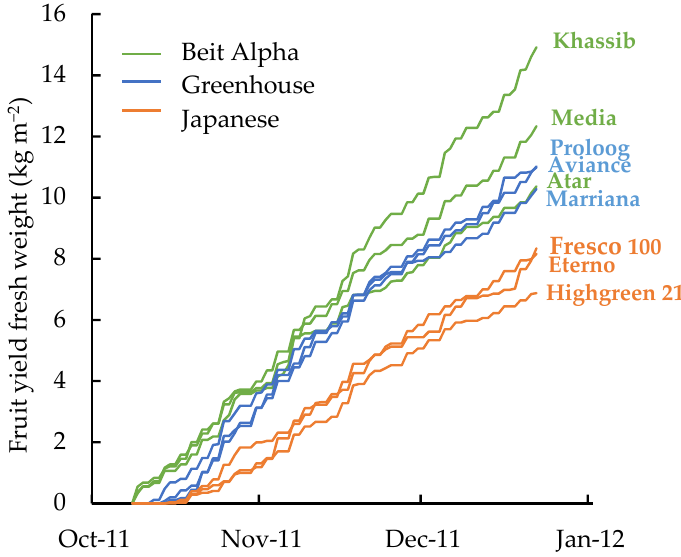
Figure 3. Cumulative fruit yield fresh weight in nine cucumber cultivars. The light extinction coefficient measured at 50 DAT, based on 95% confidence intervals, and no significant difference was observed among the different cultivars (Figure 4). The values were 0.80, 0.99, 0.90, 0.97, 0.90, 0.79, 0.93, 0.77 and 1.01 in ‘Media RZ’, ‘Khasib RZ’, ‘Atar’, ‘Proloog RZ’, ‘Marriana RZ’, ‘Aviance RZ’, ‘Eterno’, ‘Fresco 100’ and ‘High-green’, respectively. (R 2 = 0.93–0.98, p < 0.01). The average values of light extinction coefficient were 0.90, 0.89, and 0.90 in the Beit Alpha, Greenhouse, and Japanese cultivars, respectively.